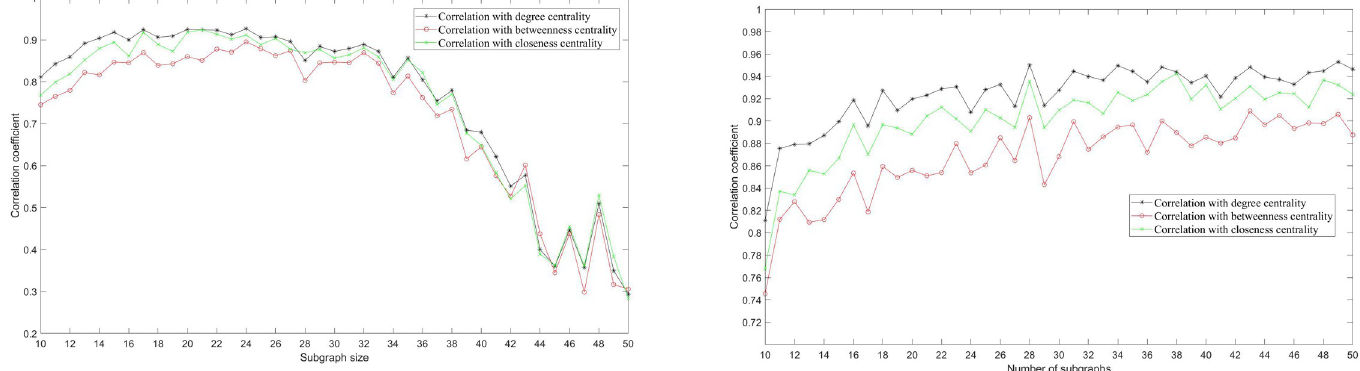
Fig 11. Correlation between the number of times each node is selected and the network centrality corresponding to Fig 6. (a) shows the result for different subgraph sizes given the number of subgraphs m = 10; (b) shows the result for different number of subgraphs given the subgraph size k = 10. The different curves represent the correlations with degree centrality, betweenness centrality and closeness